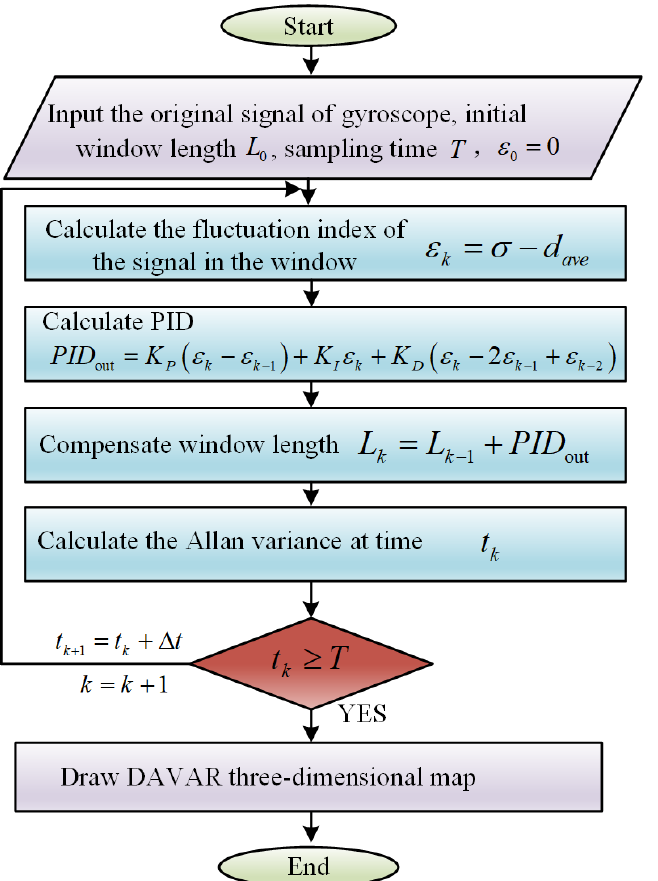
Figure 2. PID-DAVAR adaptive algorithm flow chart.